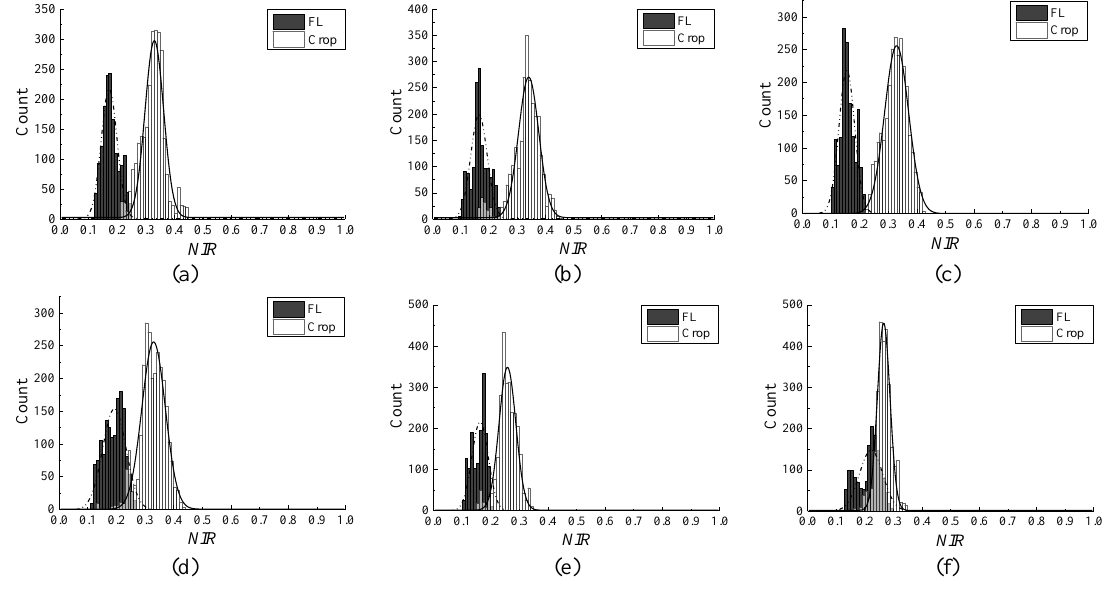
Figure 7. Histogram of NIR on ( a ) 03/12; ( b ) 03/17; ( c ) 03/25; ( d ) 03/28; ( e ) 04/02; and ( f ) 04/10 for crop types and FL.